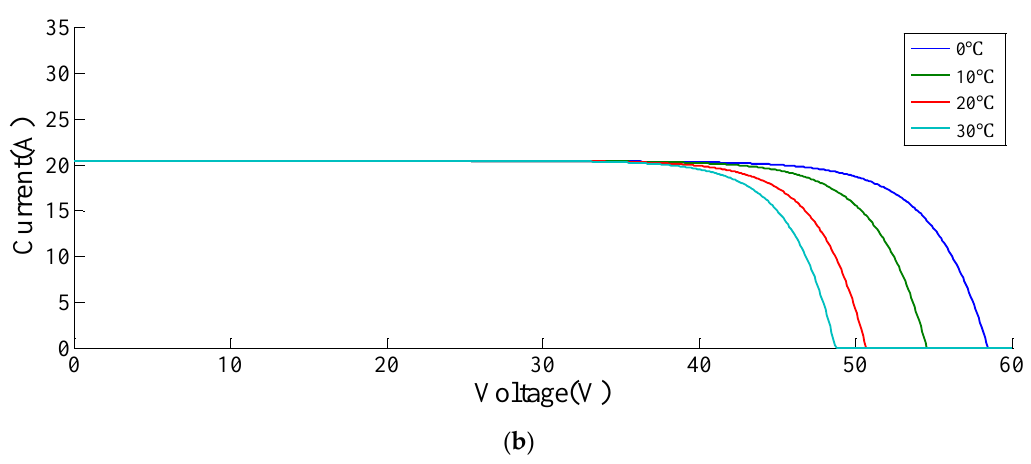
Figure 2. I-V output characteristics of PV modules in different environments. ( a ) I-V output characteristics of PV modules under different light intensity at T = 25 °C. ( b ) I-V output characteristics of PV modules under different temperatures at S = 1000 W/m 2 .